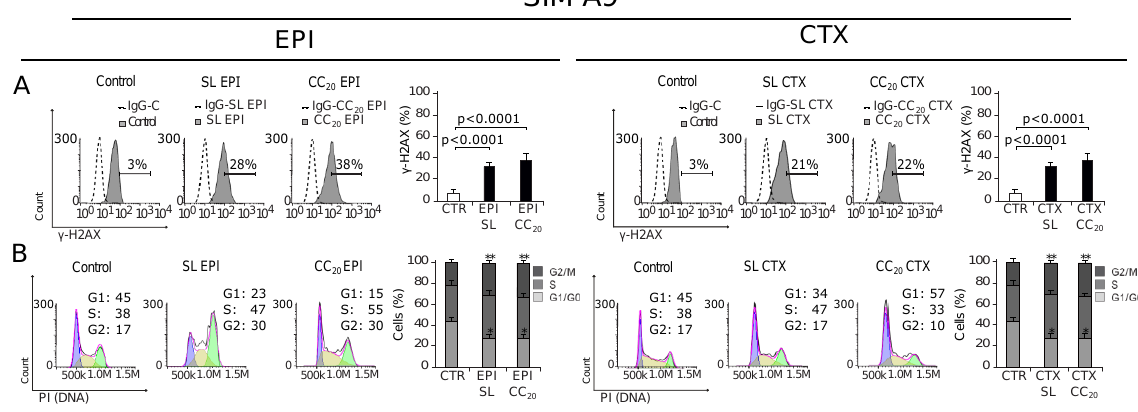
Figure 6: DNA damage and cell cycle arrest induced by low concentrations of EPI and CTX. A ) Representative histograms of nuclear damage analysis and quantification measured through γ-H2AX. Bars at right represent the mean  SD. B ) Cell cycle analysis by propidium iodide (PI) staining after treatment with SL or CC 20 of EPI or CTX in SIM-A9 for 24 h. Representative histograms (left) and bar graphs presenting mean  SD (right) are